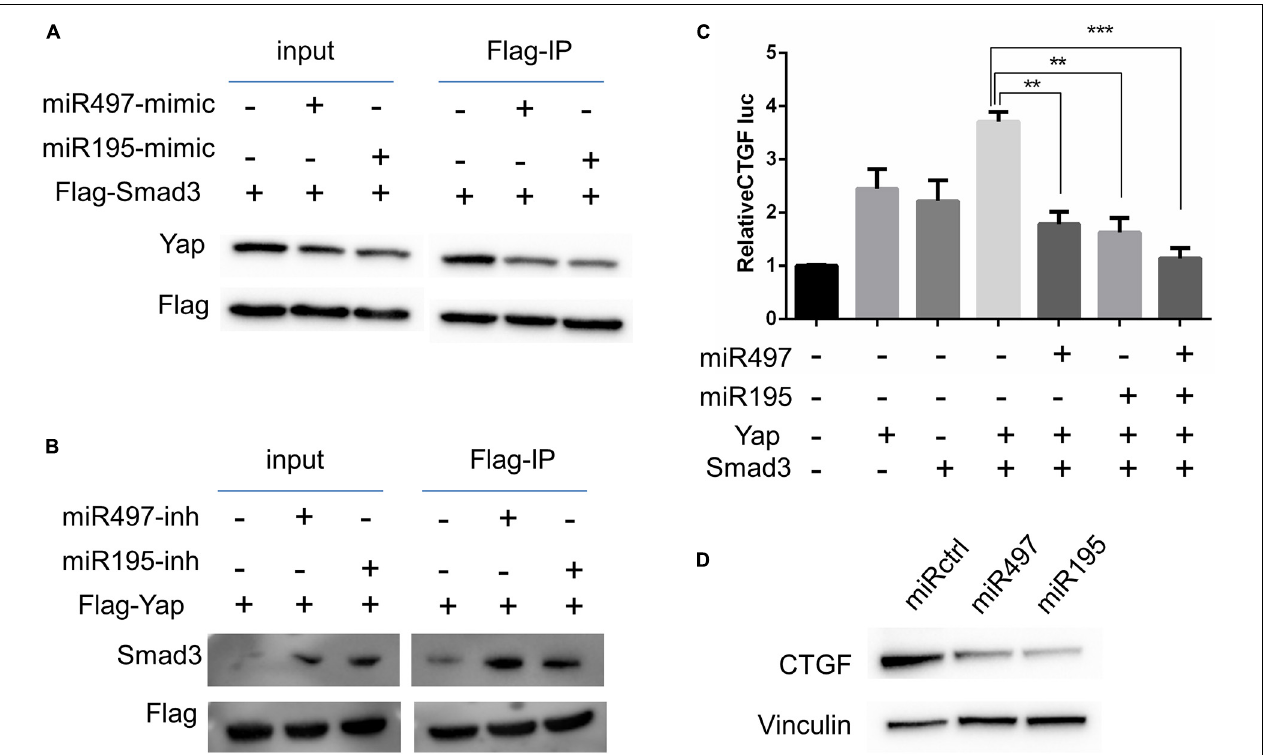
FIGURE 5 | MiR-497 and miR-195 co-ordinately attenuated Yap and Smad3 dependent transcriptional activity. (A, B) 5637 cells were transfected with expression vectors as indicated. Cell lysates were subjected to immunoprecipitation (IP) with an anti-Flag antibody and subsequent WB with indicated antibodies. (C) CTGF-luciferase reporter was co-transfected with other plasmids into 5637 cells as indicated for luciferase assay. Results are expressed as mean ± SD. ** P < 0.01 and *** P < 0.001. (D) Western blot analysis of CTGF in the cells transfected with miR-497 and miR-195 mimics.